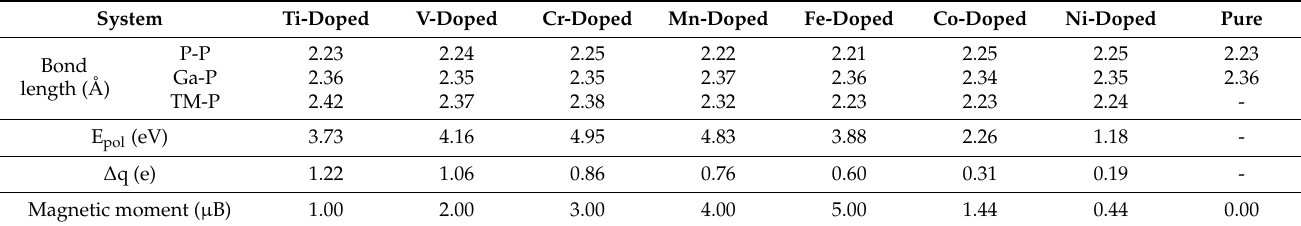
Table 1. The bond length, spin polarization energy, charge transfer, and magnetic moment of various doped systems. System Ti-Doped V-Doped Cr-Doped Mn-Doped Fe-Doped